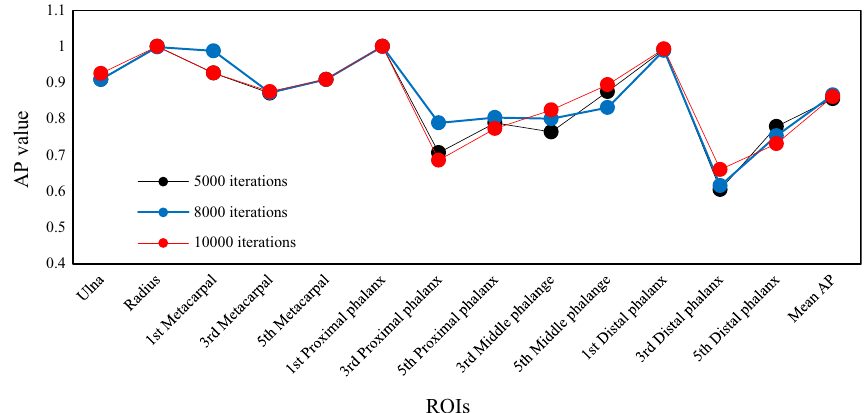
Fig. 10 AP values of the ROIs with the faster R-CNN-based